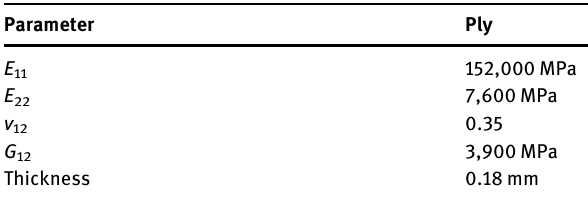
Table 2: The mechanical properties of the ply